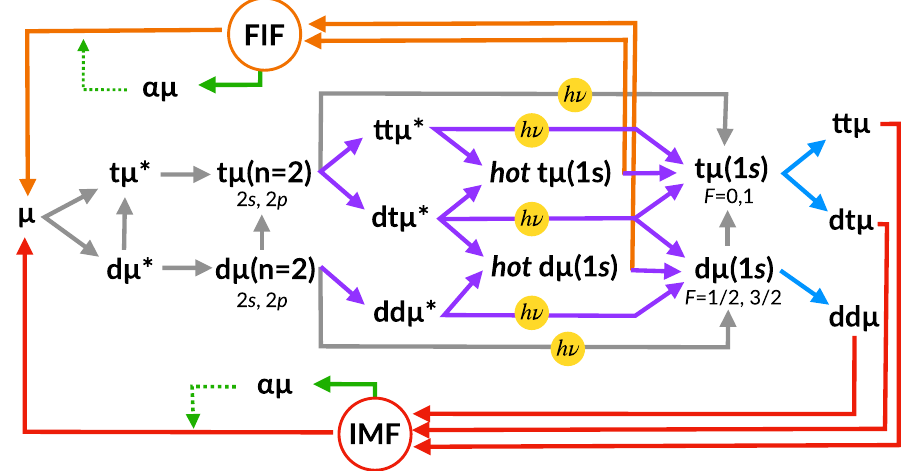
Figure 2. Reaction scheme of µ CF, including the dt µ formation based on the Vesman mechanism (VM, lightblue arrows) and subsequent intramolecular fusion (IMF, red arrows), side-path model (SPM, purple arrows), and fusion in-flight (FIF, orange arrows). The green arrows denote the αµ sticking and the dashed green arrow denotes µ reactivation from µ He. The arrows with h ν indicate X-ray emissions from the 2 p state muonic atoms and resonance states of the muonic